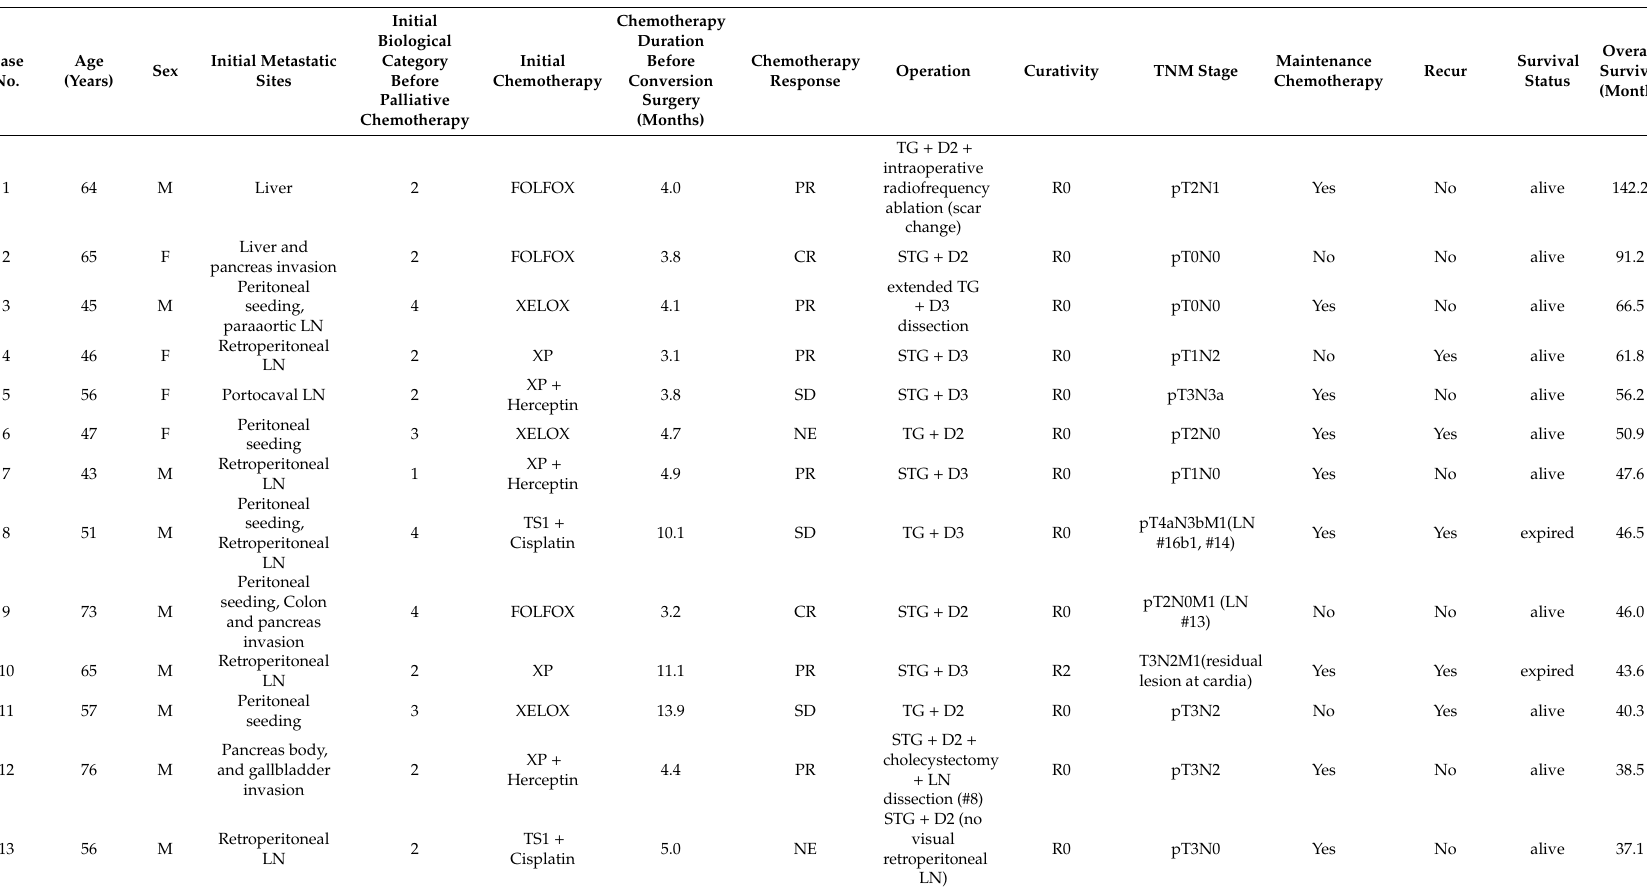
Table 3. The characteristics and clinical course of patients who showed long-term survival ( > 3 years) among patients with conversion surgery.